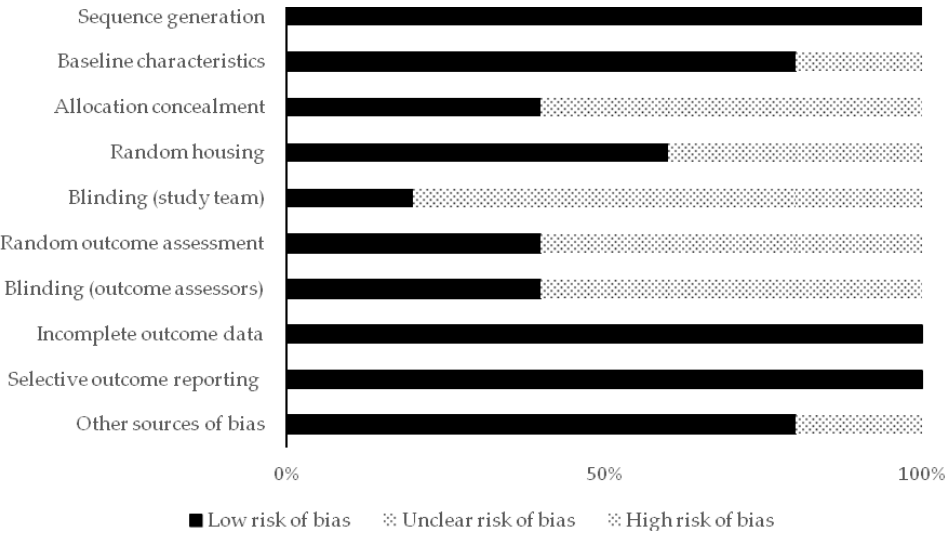
Figure 3. Risk of bias assessment scores in the in vitro studies ( n = 9) presented in percentage of articles (% of total).